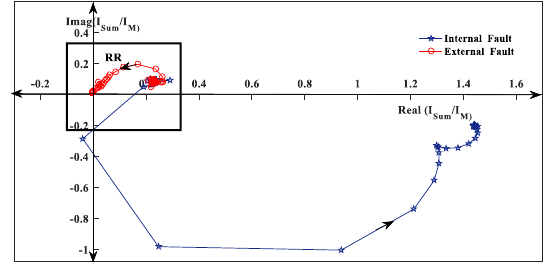
Fig. 6 The CCR for internal and external